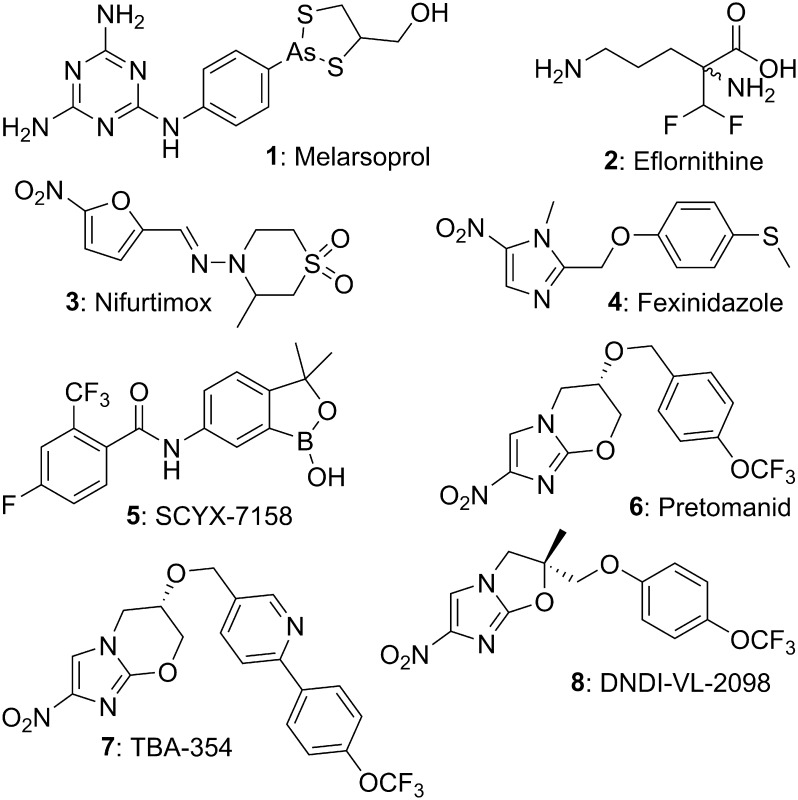
Various antitrypanosomal, antitubercular, or antileishmanial agents.